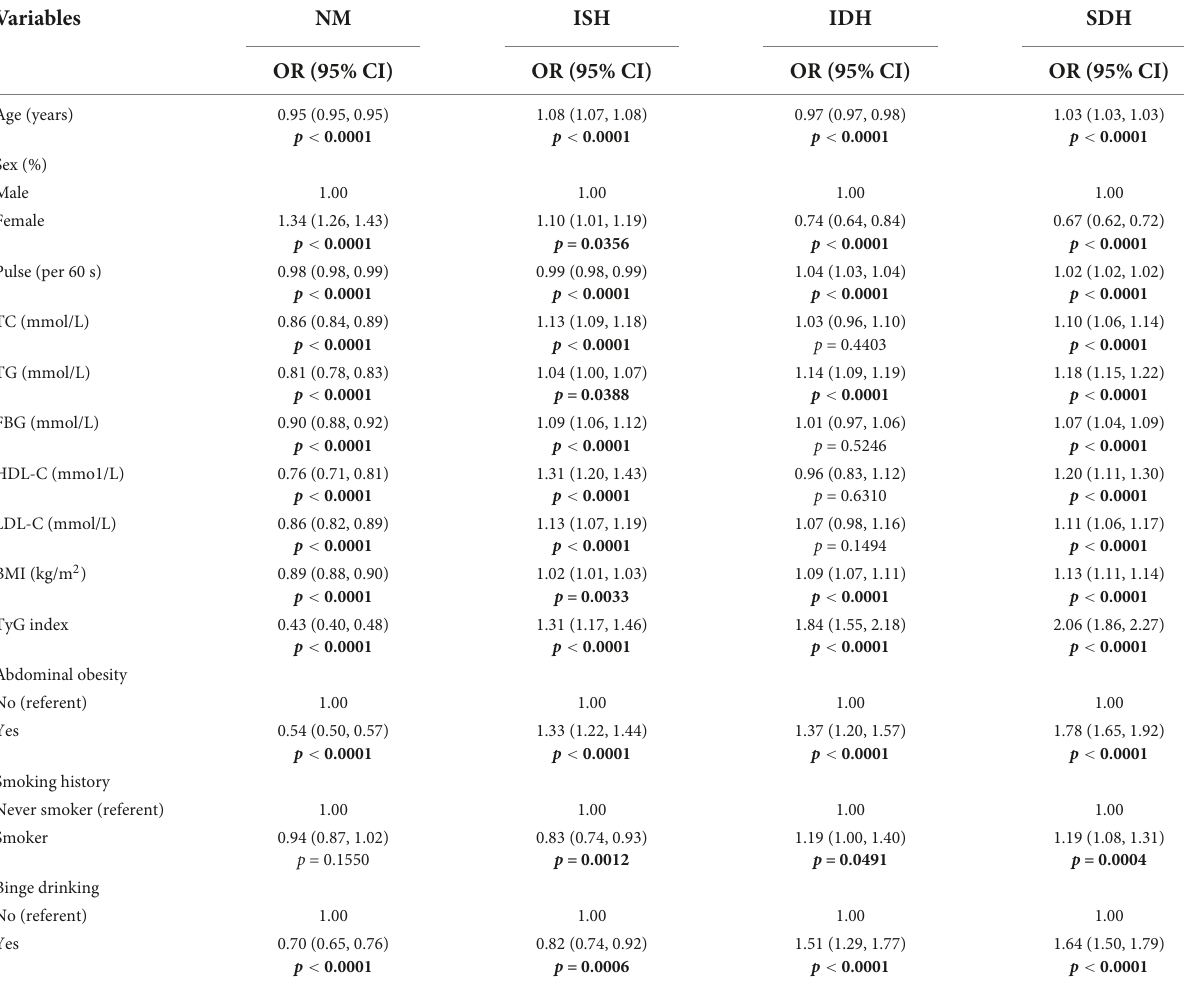
TABLE 2 Univariate logistic regression analyses of the associations between sociodemographic, clinical characteristics and lifestyles, and hypertension subtypes, Shandong, China (2007–2010).